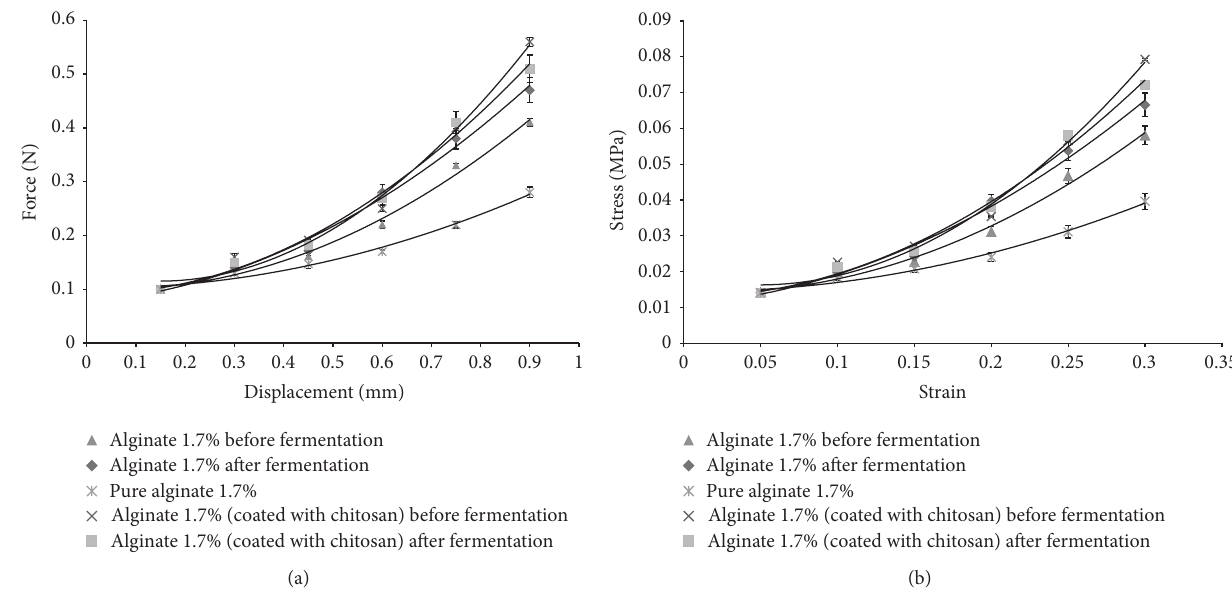
Figure 5: Comparison of the force-displacement (a) and stress-strain (b) polynomial fitted curves of the biopolymer carriers before and after the fermentation process (30% deformation, compression speed 1mm/min, and means values ± SD, 𝑛 = 30 ).